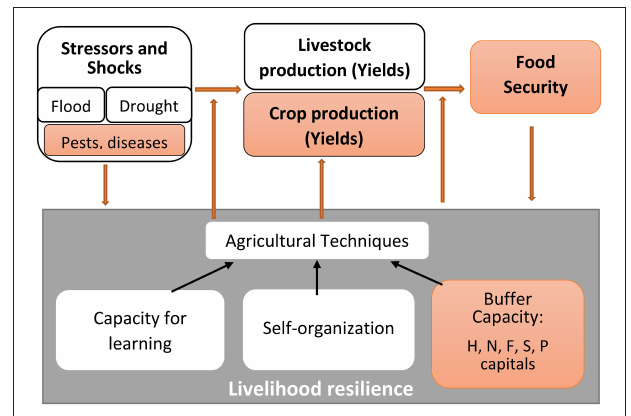
FIGURE 1 | Interrelationship between diverse sections of resilience indicator